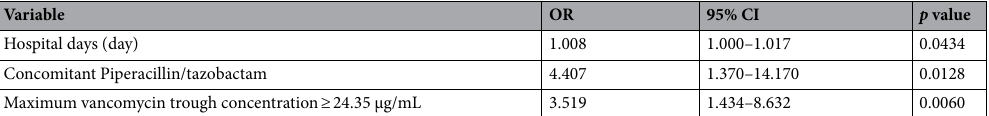
Table 4. Multivariate logistic regression analysis of risk factors for VIN. VIN vancomycin-induced nephrotoxicity, OR odds ratio, CI confidence interval. Continuous variable odds ratio is odds per single unit indicated in parenthesis.